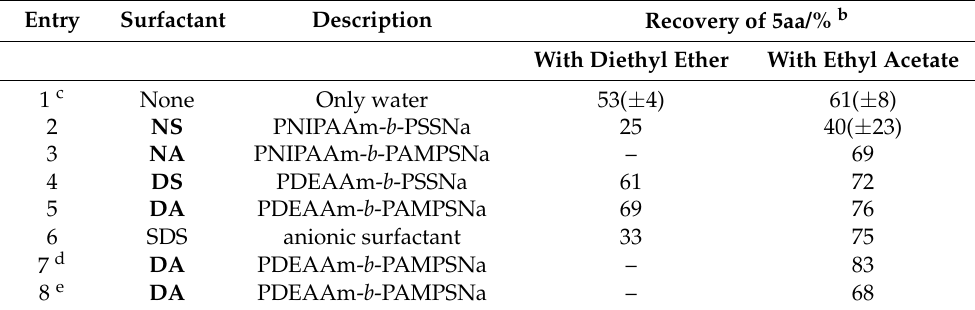
Table 4. Extraction study from model aqueous solution a